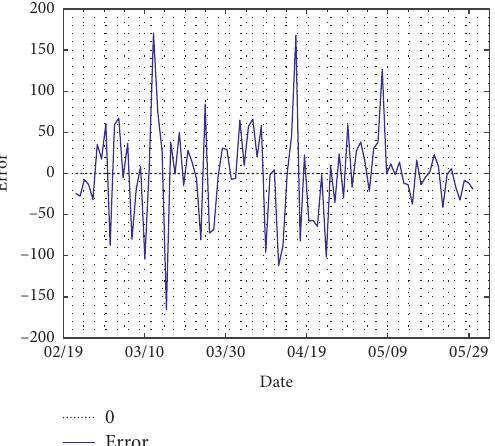
Figure 4: The fitting error of Italy with a mean absolute error of